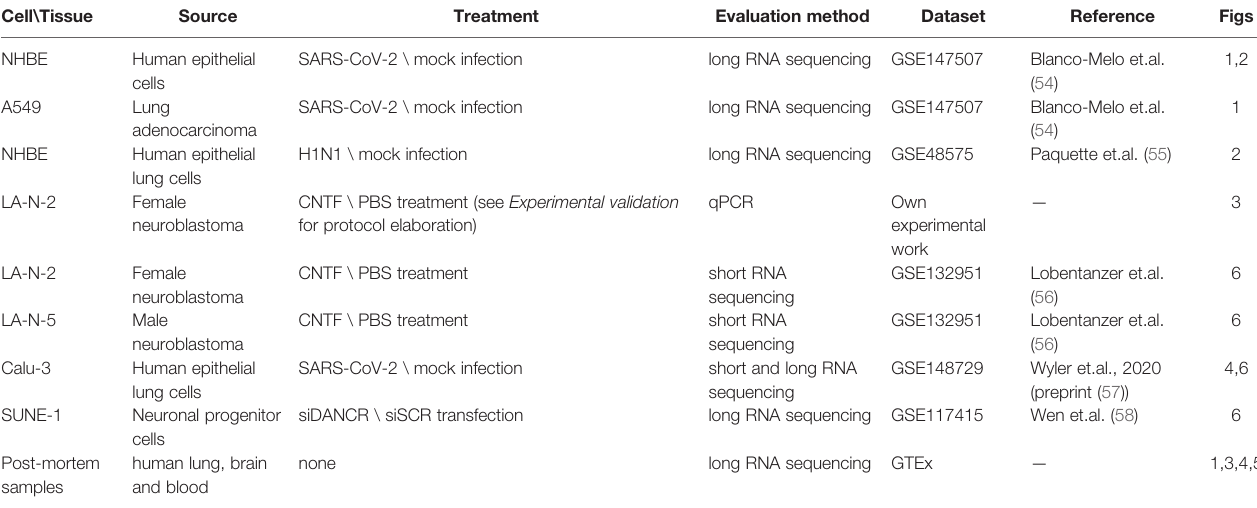
TABLE 1 | The analyzed